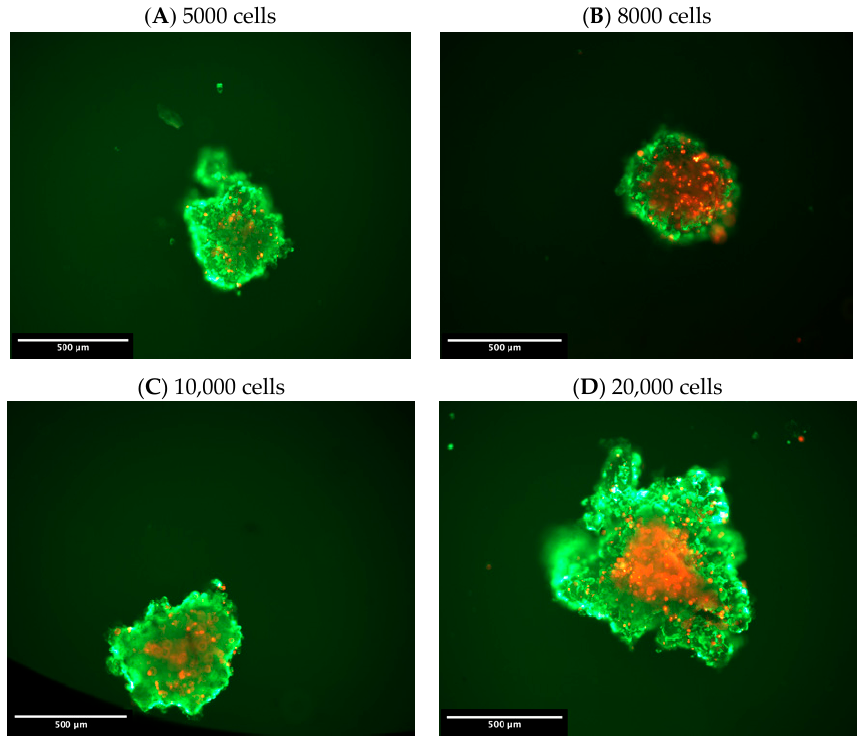
Figure 3. Morphology of the spheroid at various cell densities initially seeded at ( A ) 5000 cells, ( B ) 8000 cells, ( C ) 10,000 cells, and ( D ) 20,000 cells . Images were captured at a scale bar of 500 µm and 10X magnification . Red and green represent propidium iodide and annexin V staining, which in turn indicates the area of necrotic and apoptotic cell death, respectively . Table 1. Five - day - old SK - MEL - 2 spheroid volume and cell death fluorescence intensity . Different letters in the same column indicate significant differences between samples ( p < 0 . 05 ).